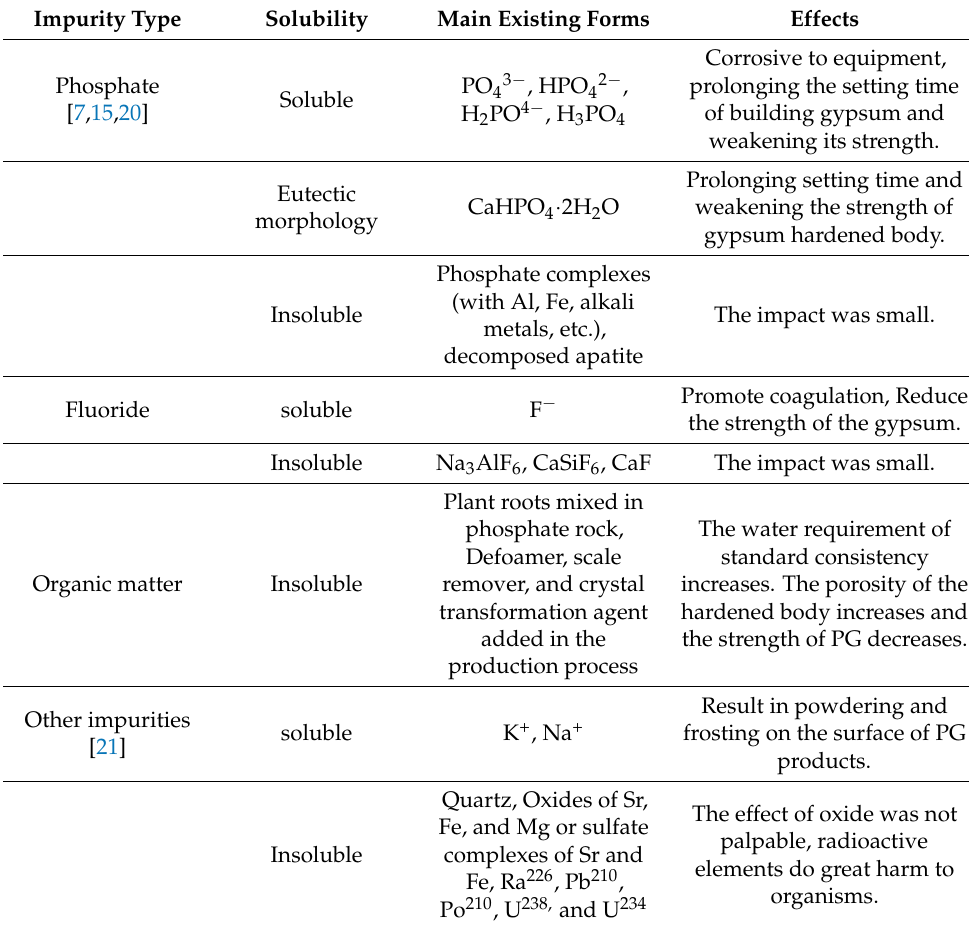
Table 1. Impurities in PG and their existing